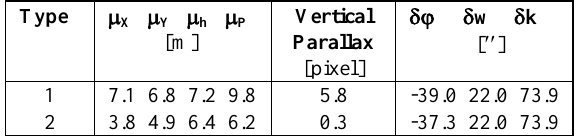
Table 1. Statistics of location accuracy and compensation values using two methods